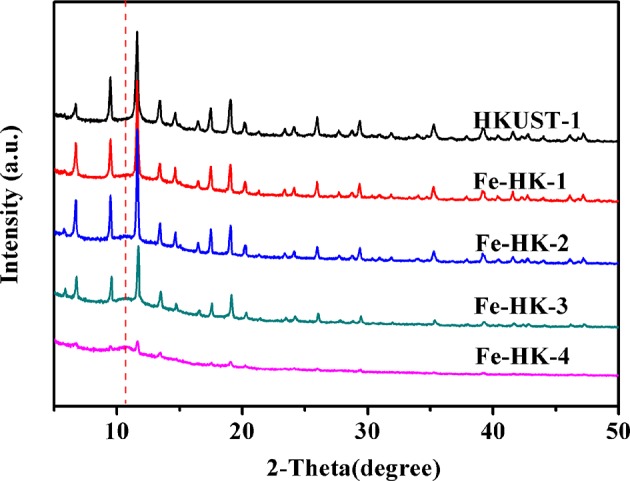
PXRD patterns of HKUST-1 and the Fe-HK samples.